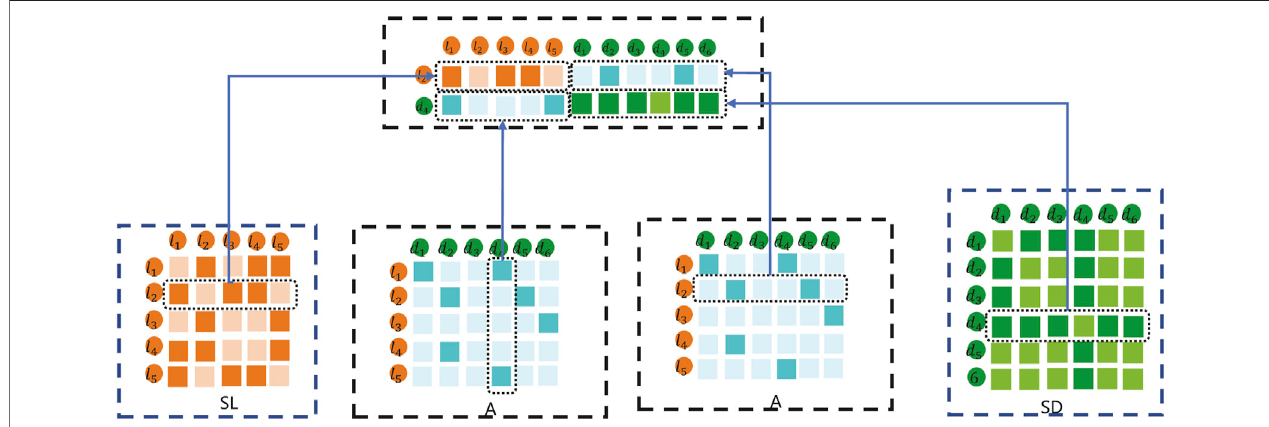
FIGURE 4 | An example of K-means embedding